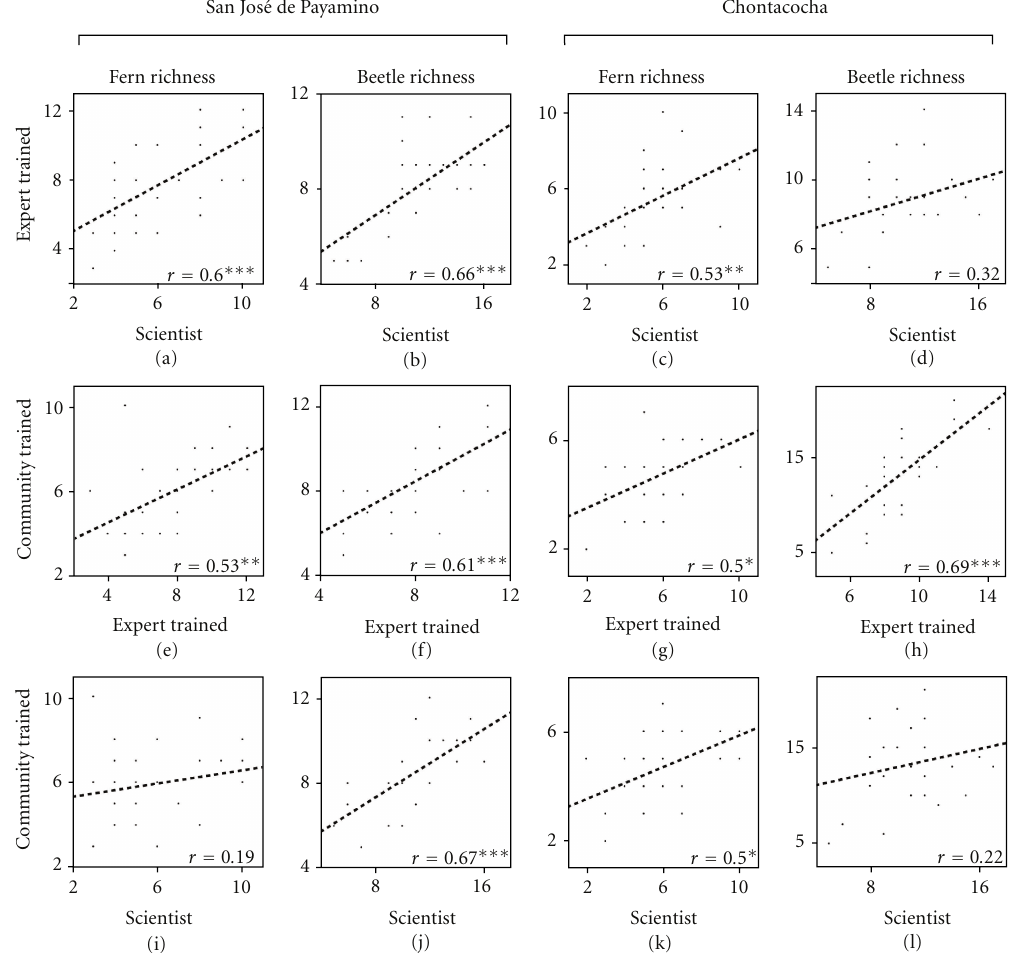
Figure 1: Correlations between scientist, expert-trained, and community-trained groups ( ∗ P < 0.05, ∗∗ P < 0.005, and ∗∗∗ P <